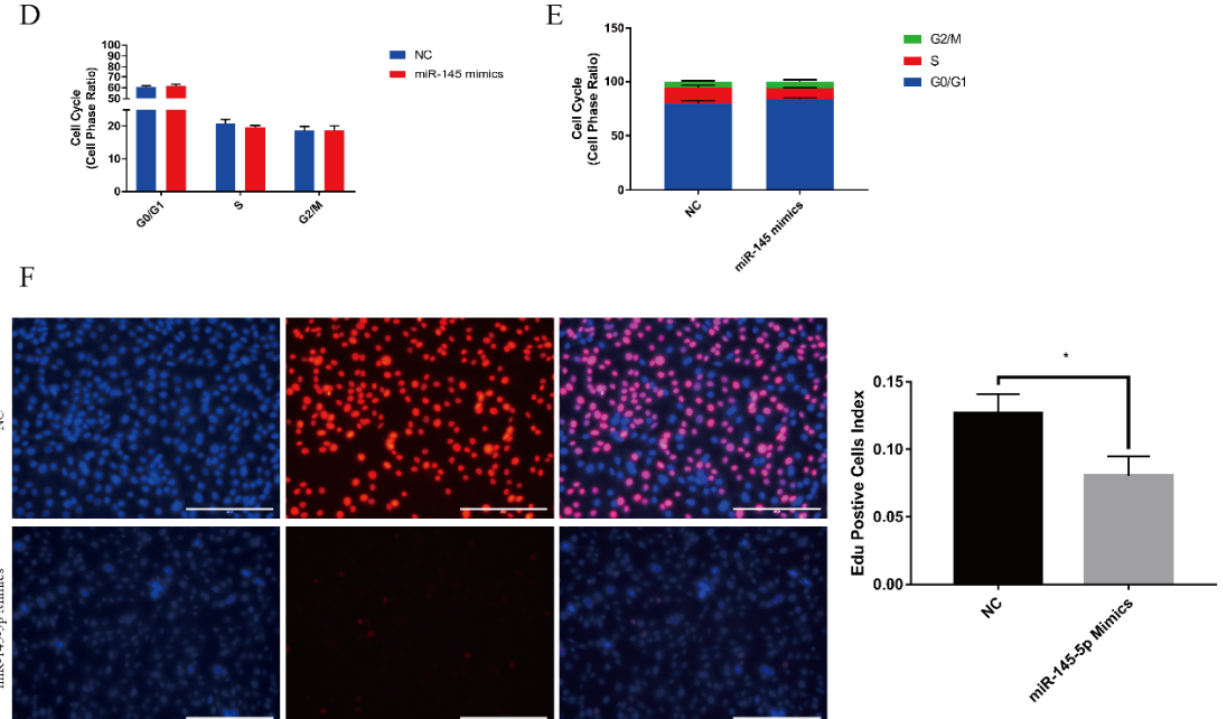
Figure 1. Inhibition of stem cell proliferation of goat hair follicles by miR-145-5p. ( A ) RT-qPCR quan- tified the expression of marker genes ( CDK1 , PCNA , CCND2 ) following miR-145-5p overexpression. ( B ) Western blotting showed the expression of proliferation marker genes (CDK1, PCNA, CCND2) following transfection with miR-145-5p mimics. ( C ) Cell cycle detection by flow cytometry following miR-145-5p upregulation. ( D , E ) The distribution of the three phases. ( F ) Distribution and rate of EdU-positive cells. No asterisk, p > 0.05; *, p < 0.05.